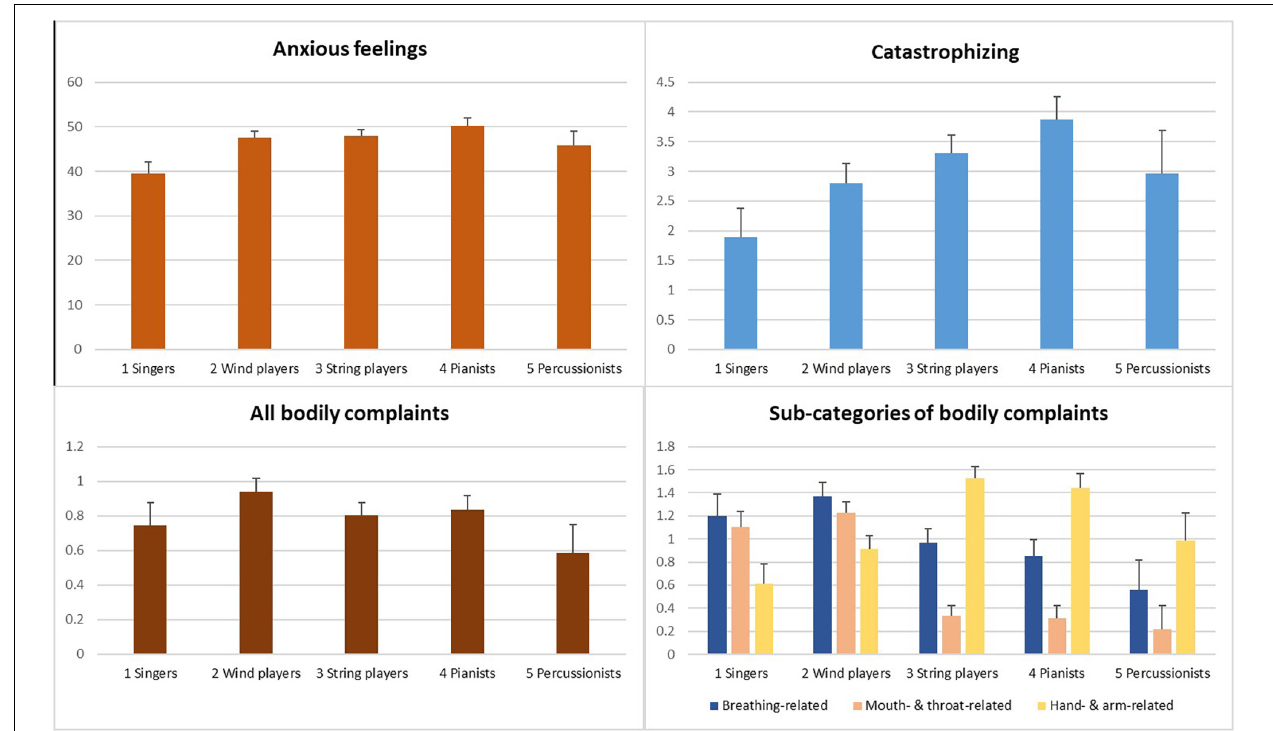
FIGURE 1 | Model-predicted marginal means ( SE s) of anxious feelings, catastrophizing, all bodily complaints, and sub-categories of bodily complaints for the five instrument groups (see Supplementary Tables 6 – 8 for all pairwise comparisons). TABLE 2 | Results of the linear regression analyses for anxious feelings. Simple regression Multiple